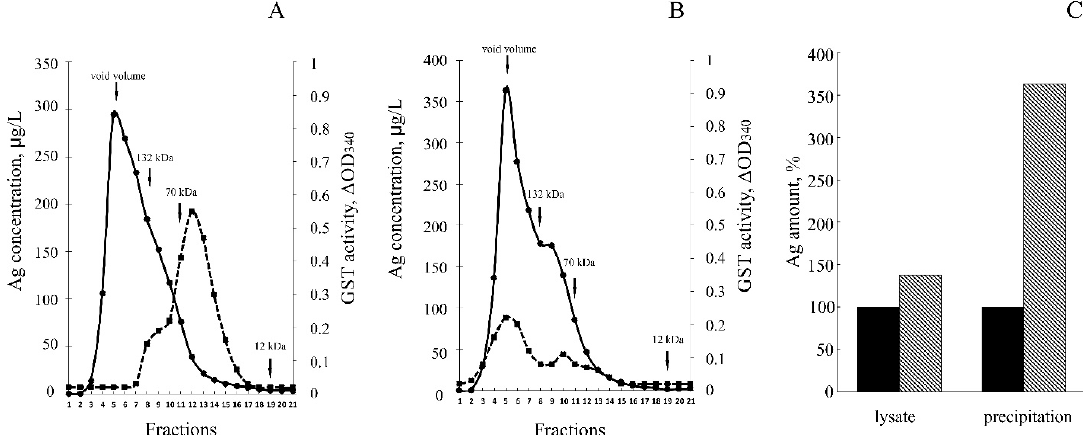
Figure 4. Distribution of silver and GST enzymatic activity in cytoplasm of E. coli cells synthetizing GST ( A ) and GST-hNdCTR1 ( B ). Solid line: silver concentration; dotted line: GST enzymatic activity. The details of chromatographic analysis are described in Methods (Section 2.6). The arrows show elution rate of marker proteins: 132 kDa—human ceruloplasmin, 70 kDa—bovine serum albumin, 12 kDa—horse cytochrome C . ( C ) Amount of silver precipitated by antibodies to CTR1. Dark bar: E. coli BL21(DE3)/pGEX-4T-1; shaded bar: E. coli BL21(DE3)/pNdCTR1.